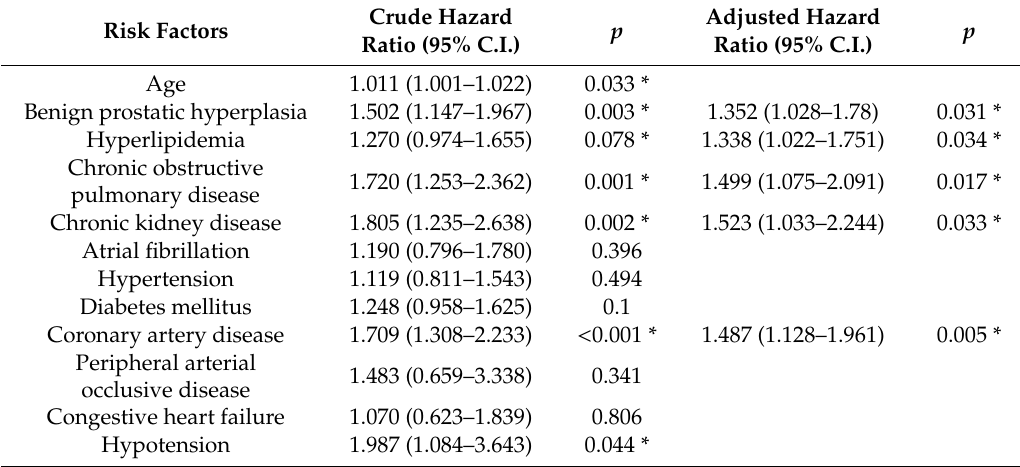
Table 2. Risk factors for one-year recurrent ischemic stroke.